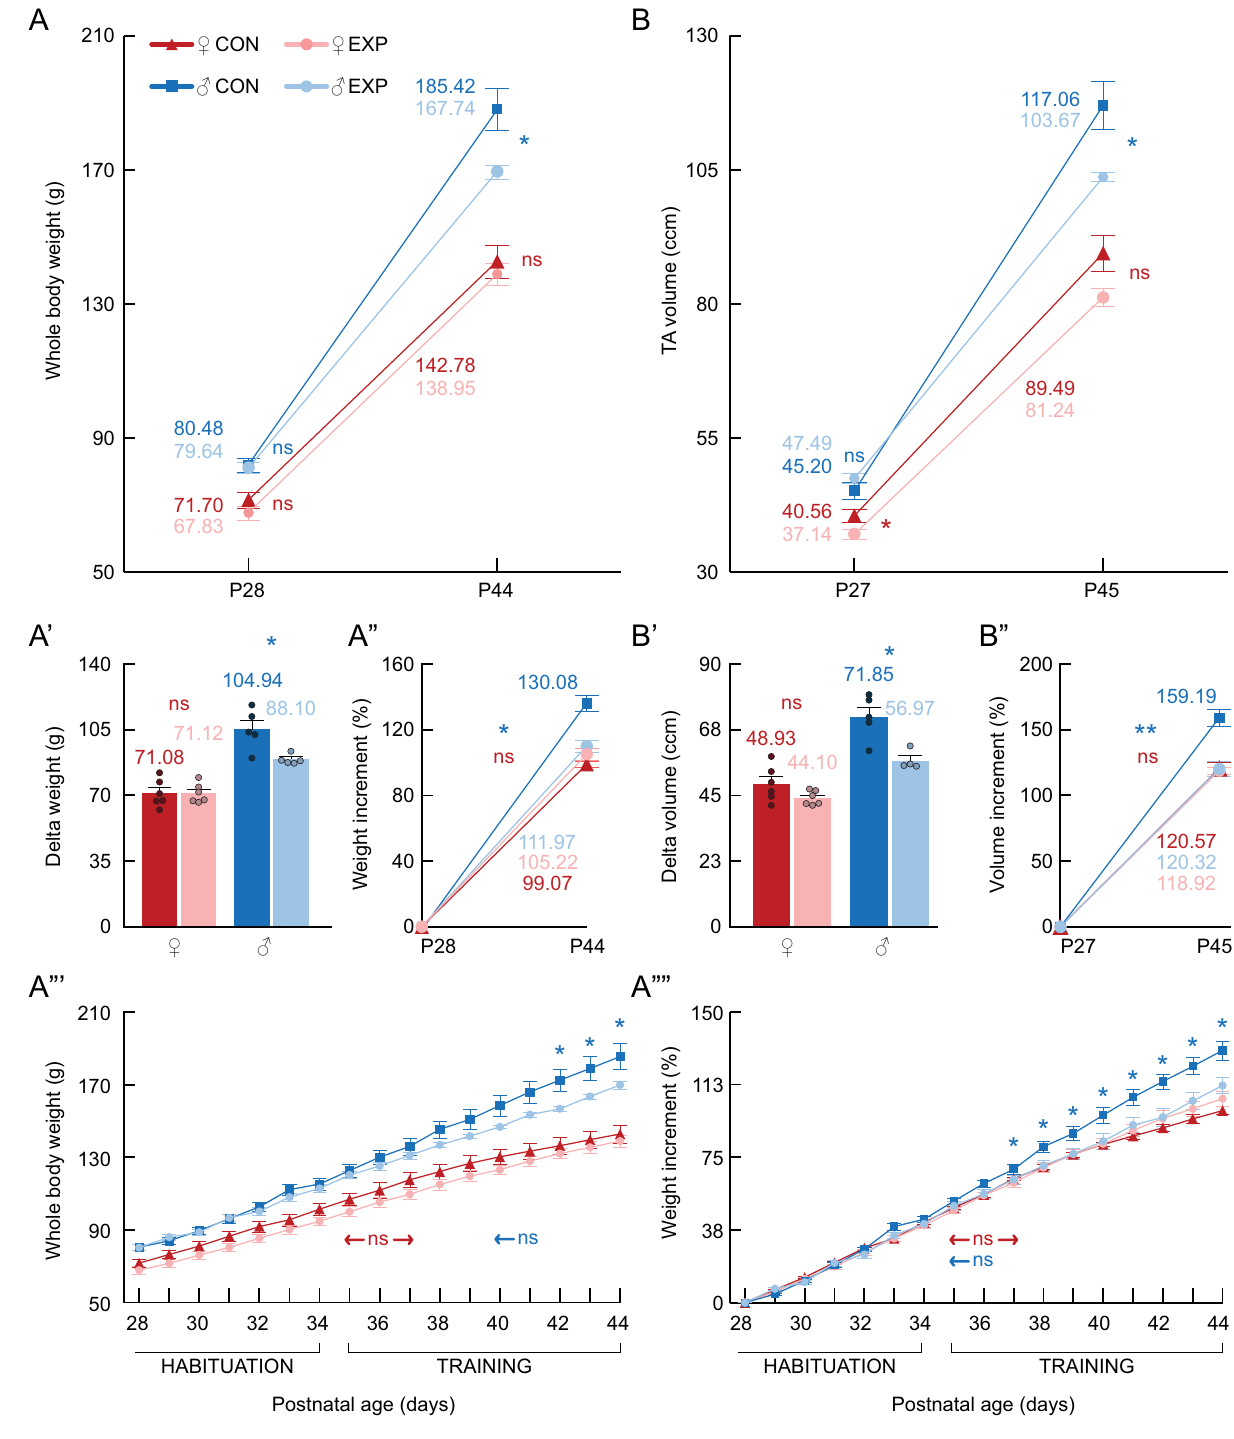
Figure 6. Body weight and TA volume of control and experimental rats. ( A ) Whole-body weight (g). In males, the split-plot ANOVA revealed an interaction between age and treatment in body-weight (F 1,9 = 7.46, p = .023). Females showed no interaction (F 1,10 < 0.001, p = 0.993). ( A’ ) Delta body weight. ( A” ) Percentual increment of body weight. ( A”’ ) Daily BW (g). ( A”” ) Daily relative BW percentual increment (%). ( B ) TA volume (ccm). In males, the split-plot ANOVA revealed an interaction between age and treatment in TA volume (F 1,9 = 26.70, p < .01). Females showed no interaction (F 1,10 = 3.26, p = 0.101). ( B’ ) Delta TA volume. ( B” ) Percentual increment of body weight (%). Statistics : Between-subjects effects were followed with Fisher’s LSD post-hoc. Paired T-test was used for within-subjects comparisons. Unpaired T-test was used in delta and increment between-subjects comparisons. Blue stars (*): male control versus trained. Red stars (*): female control versus trained. Values represented as mean and SEM. Significance levels: * p < .05, ** p < .01, *** p < .001, **** p < .0001, ns: p >